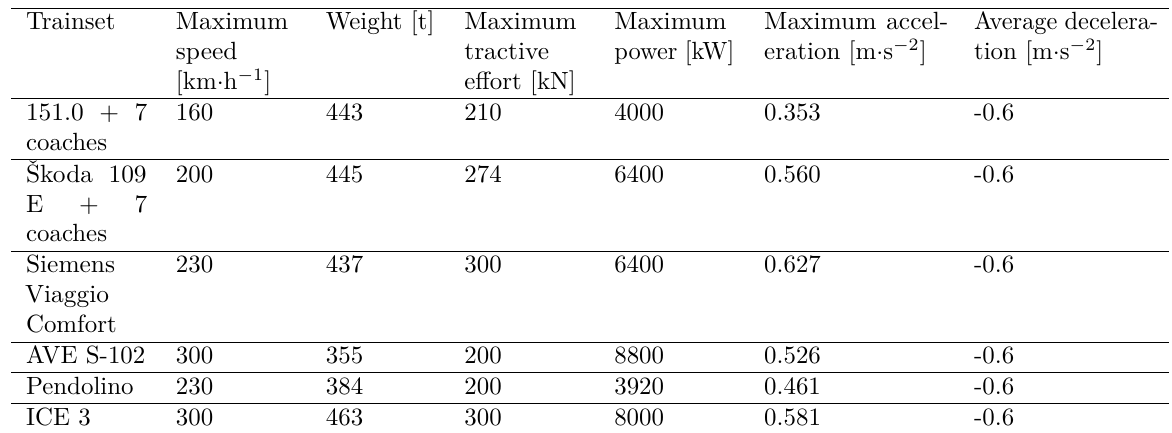
Table 1. Basic characteristics of the vehicles simulated, source: Authors.